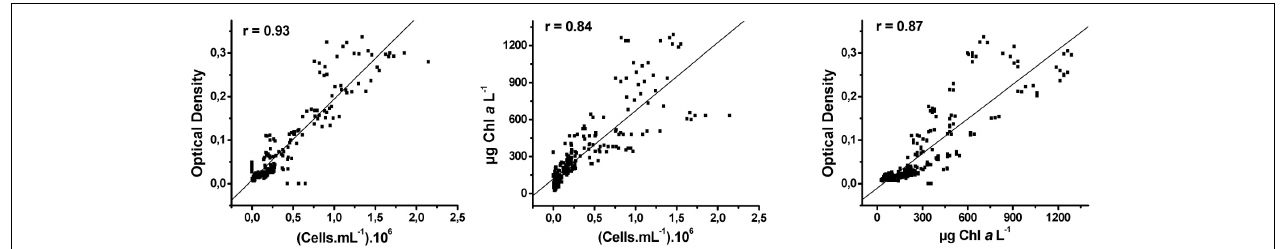
FIGURE 1 | Correlation of Pearson between cell density, optical density, and Chl a concentration.